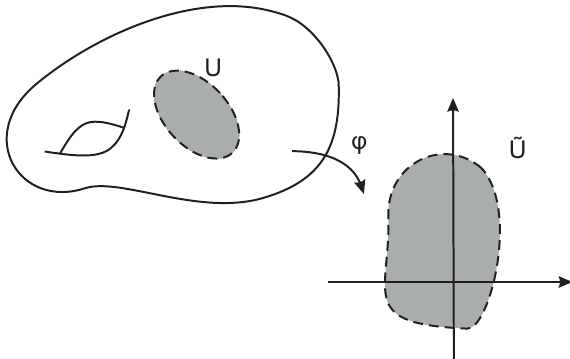
Figure 5. An example of a coordinate chart. The figure illustrates an example of a coordinate chart from U to U . r